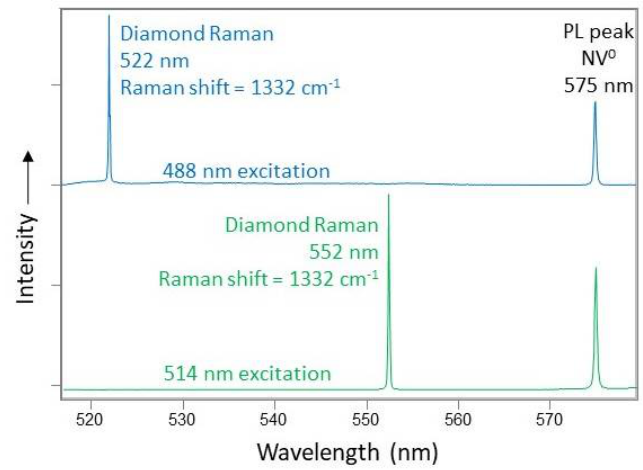
Figure 4. PL spectra were collected on the same diamond using two different lasers (488 and 514 nm) at liquid nitrogen temperature. The resulting spectra are plotted against the wavelength. Each laser shows a different location for the diamond Raman line based on the excitation wavelength. For both lasers, the energy difference between the excitation wavelength and the Raman line is constant—1332 cm −1 . Each spectrum shows the luminescence feature NV 0 and the activation for its zero-phonon line (ZPL) is fixed at 575 nm regardless of the excitation source.